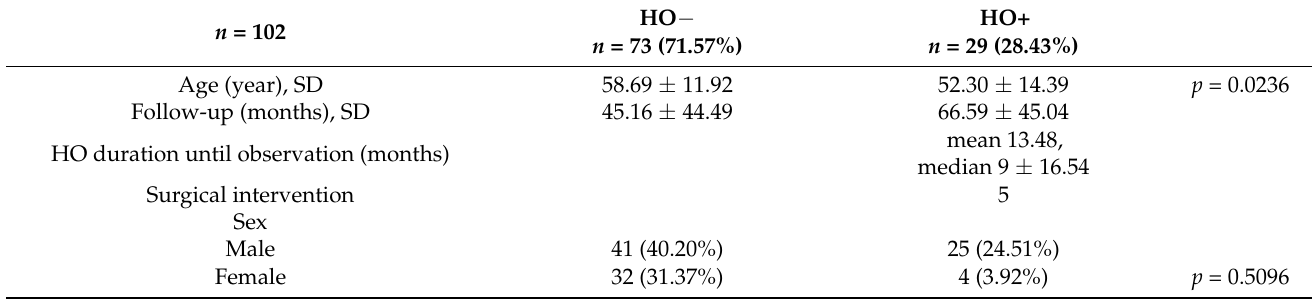
Table 1. Clinical details of 102 patients after reconstruction of continuity defects of maxilla and mandible with fibular free flaps. n =